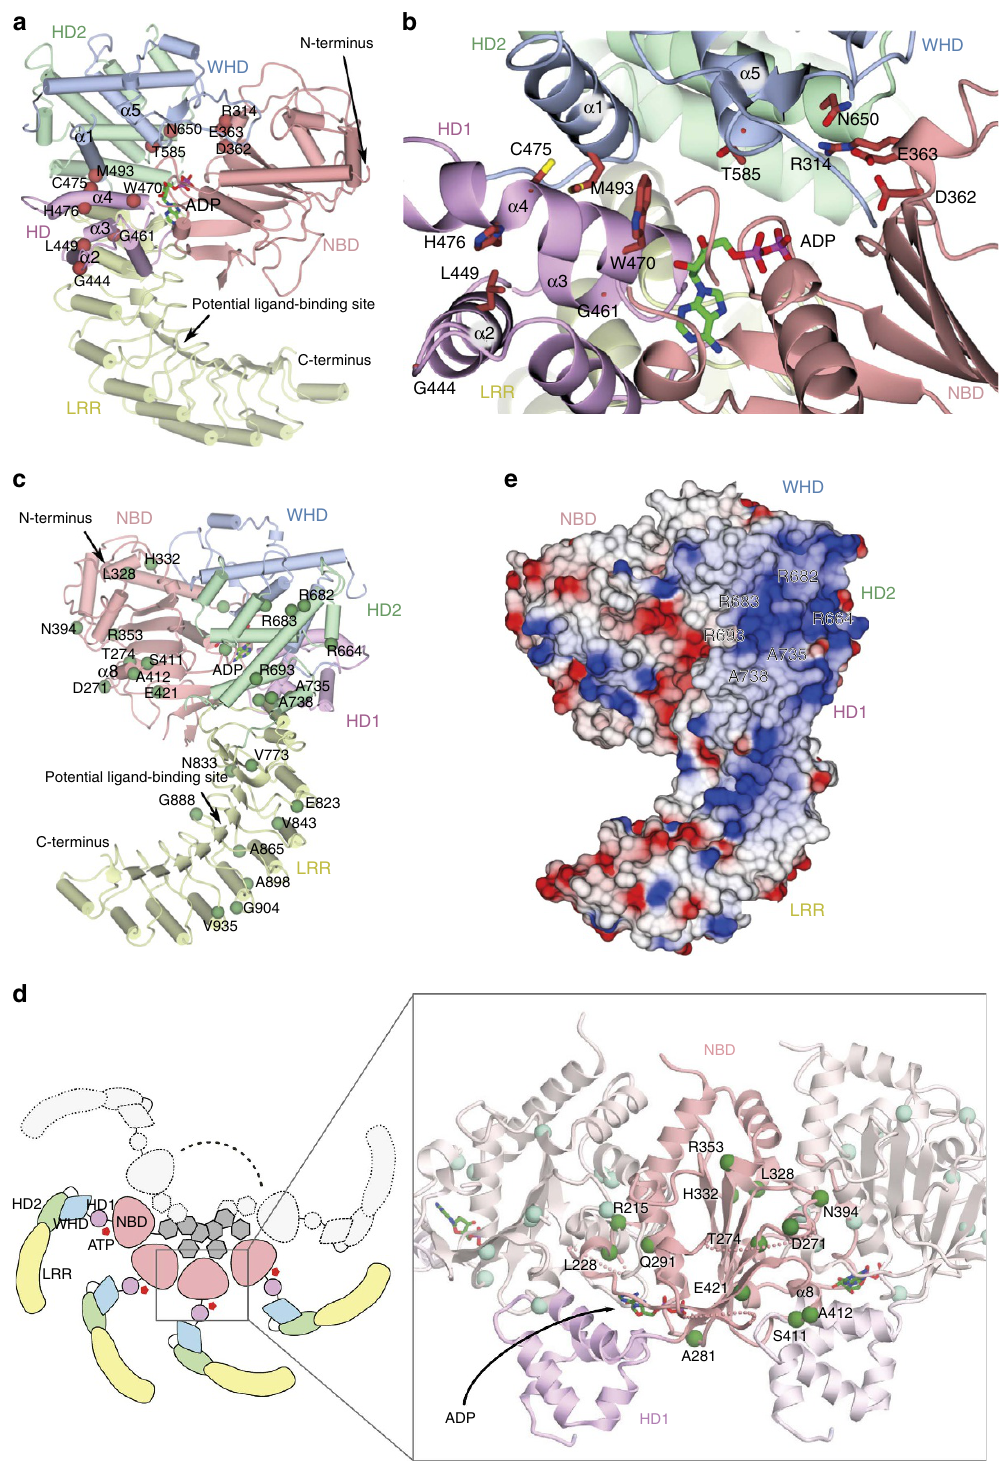
Figure 5 | Disease-related mutations. ( a ) Mapping of the BS/EOS-associated mutations in the structure of Oc NOD2. Mutated residues are shown as coral spheres. ( b ) Detailed view of a . Mutated residues are shown as coral sticks. ( c ) Mapping of CD-associated mutations in the structure of Oc NOD2 rotated 180 (cid:2) from the orientation shown in a . Mutated residues are shown as green spheres. ( d ) Putative oligomer model of NOD2. The oligomer model shown in cartoon (left). Magnified view of the NBD–HD1 region in the three adjacent protomers of NOD2 (right). The oligomer model is constructed by superimposing the Oc NOD2 structure onto the CED4 octamers (PDB code 3LQQ) using the NBD domain as reference. The middle protomer is coloured in pink (NBD) and purple (HD1) and the rest of the protomers are shown in light colours. CD-related mutations in the NBD domain are shown as green spheres in the middle protomer and as palegreen spheres in the adjacent protomers. ( e ) Electrostatic surface potential of Oc NOD2 shown in the same orientation as in c . CD-related mutations located on the positively charged surface of HD2 are